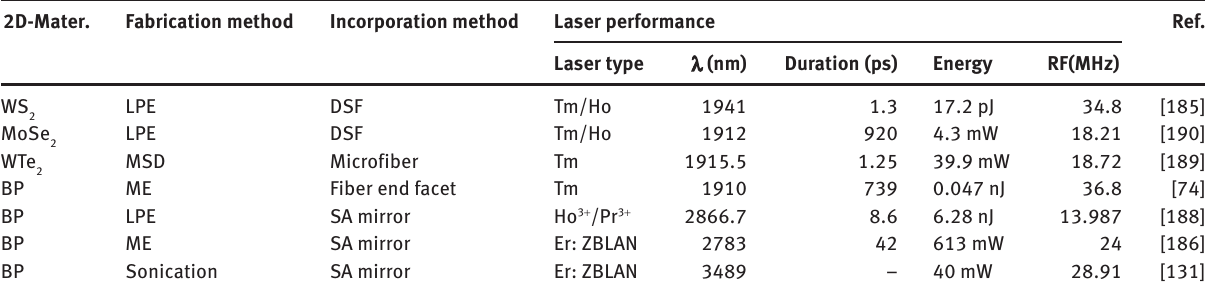
Table 4: Summarization of mode-locked fiber lasers with transition-metal dichalcogenides (TMDCs) and black phosphorus (BP) saturable absorbers (SAs) at mid-infrared wavelengths.